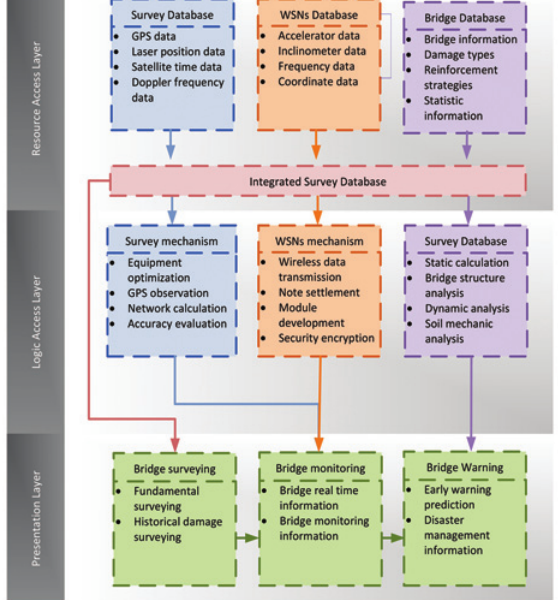
Fig. 3. Web-based bridge scours monitoring system